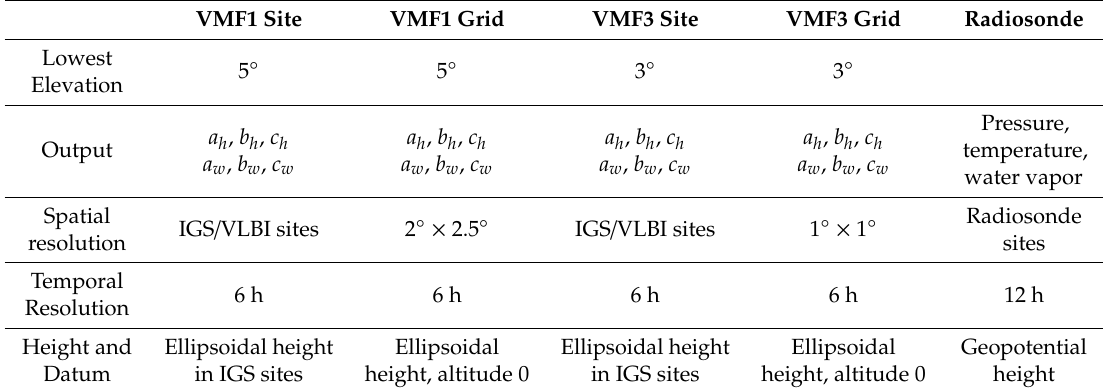
Table 1. Summary of VMF1 and VMF3 and radiosonde